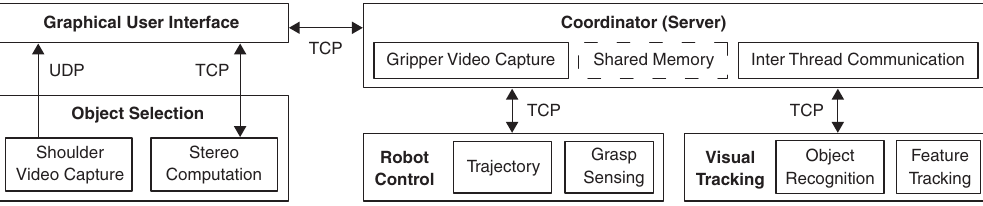
trajectory of the Manus ARM, grasps the object, and returns it to the